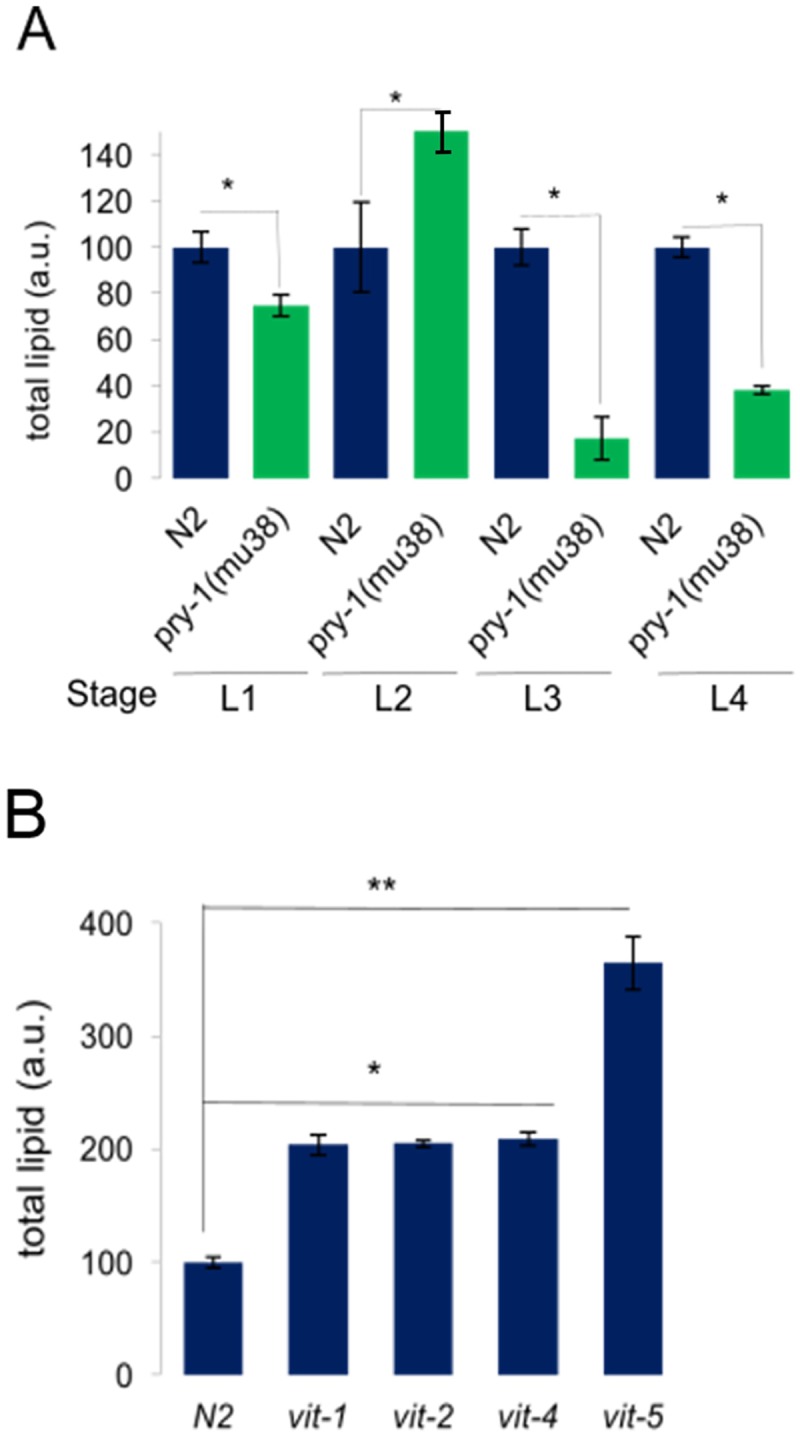
Lipid levels in pry-1(mu38) and vit mutants.(A) Quantification of Oil Red O staining intensity in pry-1(mu38) and wild-type animals at different developmental stages. Lipids are lower in pry-1 mutants at all stages except L2. (B) Quantification of Oil Red O staining in N2 and vit mutants during the young adult stage. Lipid levels are higher in vit-1(ok2616), vit-2(ok3211), vit-4(ok2982), and vit-5(ok3239) animals. Data represents the mean of at least two replicates and error bar represents the SEM. *p < 0.01, **p < 0.001.